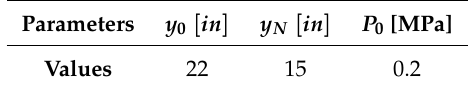
Table 1. Initial parameters of pneumatic artificial muscles